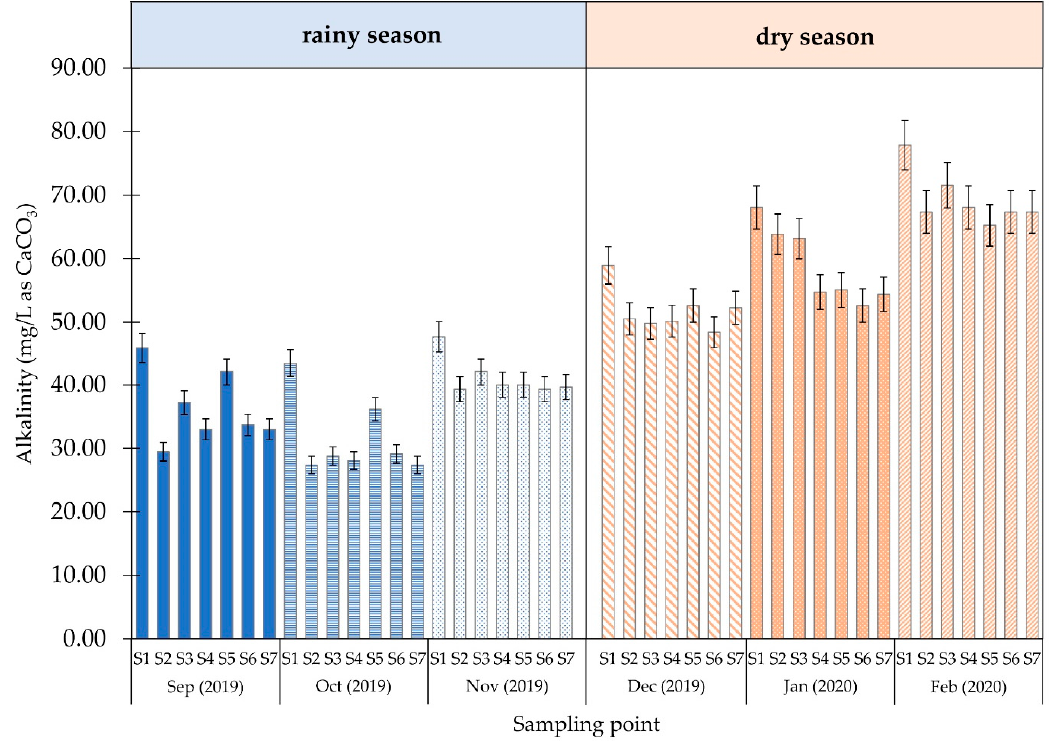
Figure 3. Alkalinity of water at each sampling point.